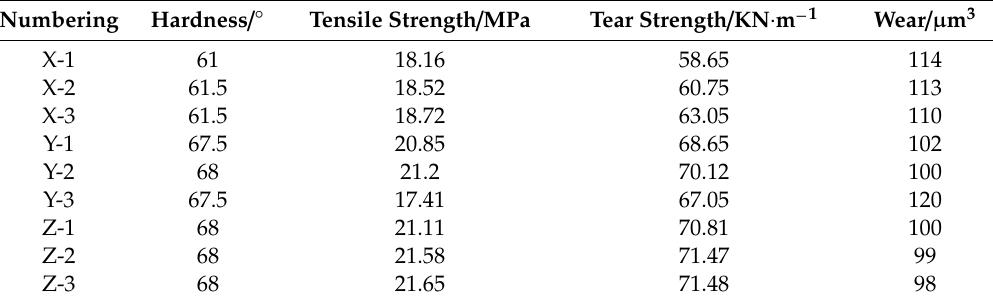
Table 6. Physical and mechanical properties of extruded